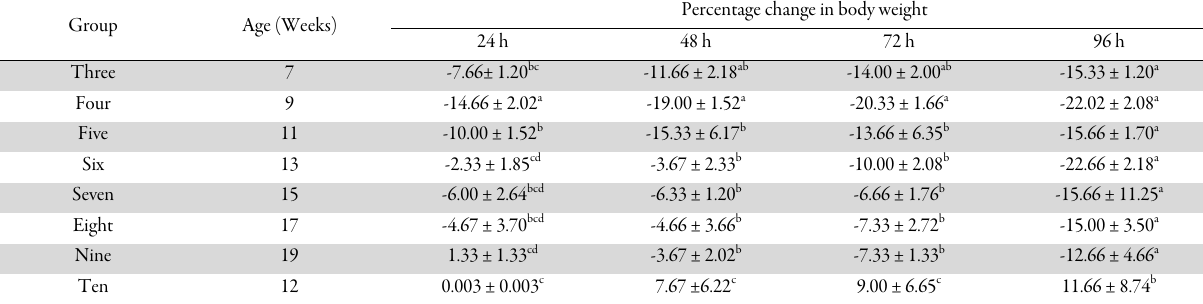
Table 4. Percentage changes in body weight of alloxan-induced diabetic rats of varying ages monitored for 96 h